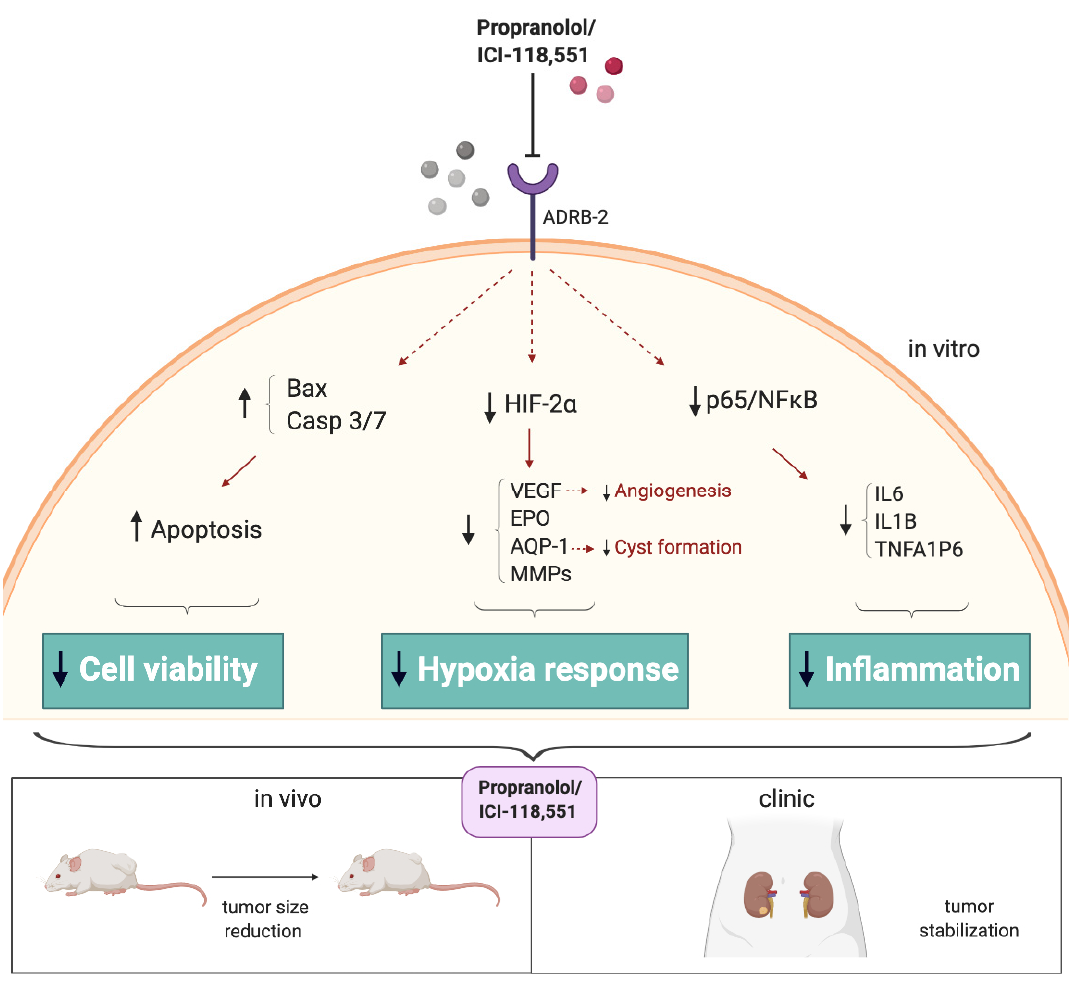
Figure 7. Antitumor benefits shown by ADRB-2 antagonists in VHL-derived ccRCC. Propranolol and ICI-118,551 have shown therapeutic benefits both in vitro and in vivo—on ccRCCs, by triggering key processes like apoptosis, increasing Bax or Caspases 3 / 7 expression, targeting and impairing the expression and signaling of molecules such as HIF and its targets, and decreasing NFkB / p65 signaling, showing anti-tumoral e ff ects in vivo. ADRB-2 antagonists could be used as promising therapeutic agents to treat RCCs, acting through inhibition of cancer cell proliferation, tumor angiogenesis, and inflammation.